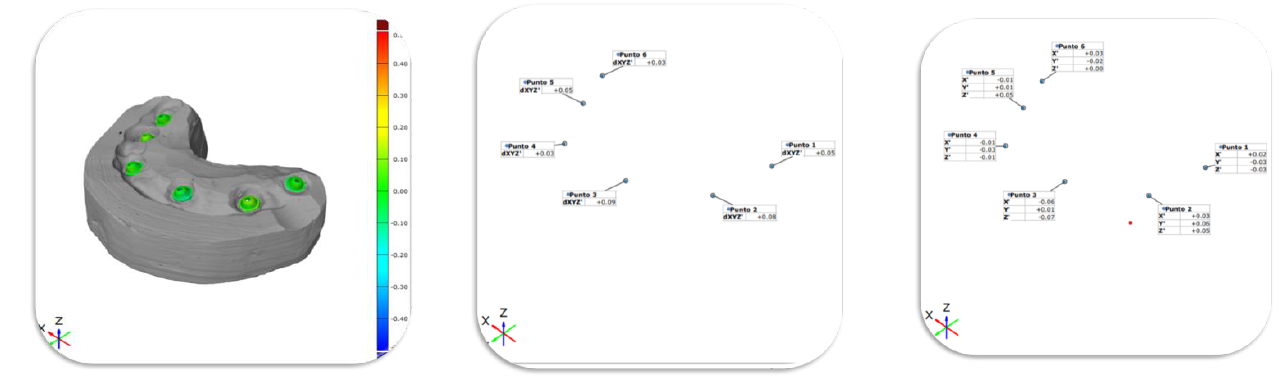
Figure 3. Points identified in the analysis. Rear points were those with the higher distance between the two models. The mean distance by considering the full sample of 51 observations was +0.11 (Std. Dev. 0.06). Furthermore, discrepancies on the three axes X, Y and Z were computed for the three axes (Table 3). Table 3. Mean cumulative discrepancies on the three axes X, Y, and Z.